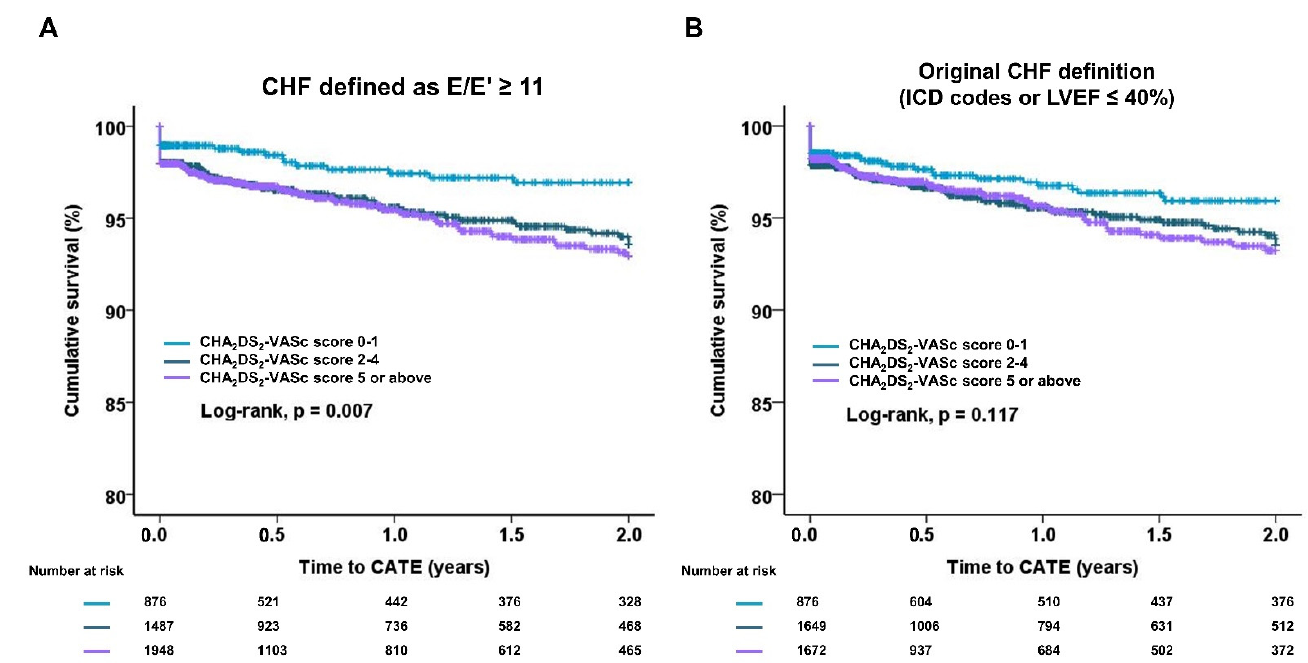
Figure 2. Kaplan–Meier survival analysis of different definitions for CHF: CHF of CHA 2 DS 2 -VASc scores was defined as E/E’ ≥ 11 ( A ) and as originally described ( B ). CHA 2 -DS 2 -VASc score categories show significantly increasing risk of CATE with increasing scores when CHF is defined as E/E’ ≥ 11 (log-rank test, p = 0.007), but not when defined by the original definition (log-rank, p = 0.117). LVEF, left ventricular ejection fraction.